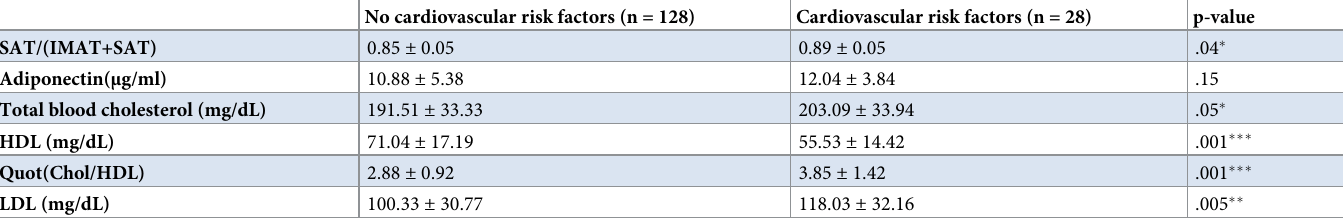
Table 6. Group comparison using between subjects with pre-existing cardiovascular risk factors in history. A statistically significant difference concerning the ratio between subcutaneous adipose tissue and intramuscular adipose tissue (SAT/(SAT+IMAT) could be indicated between the two groups using Kruskal-Wallis-Test. Values are shown in (mean ±